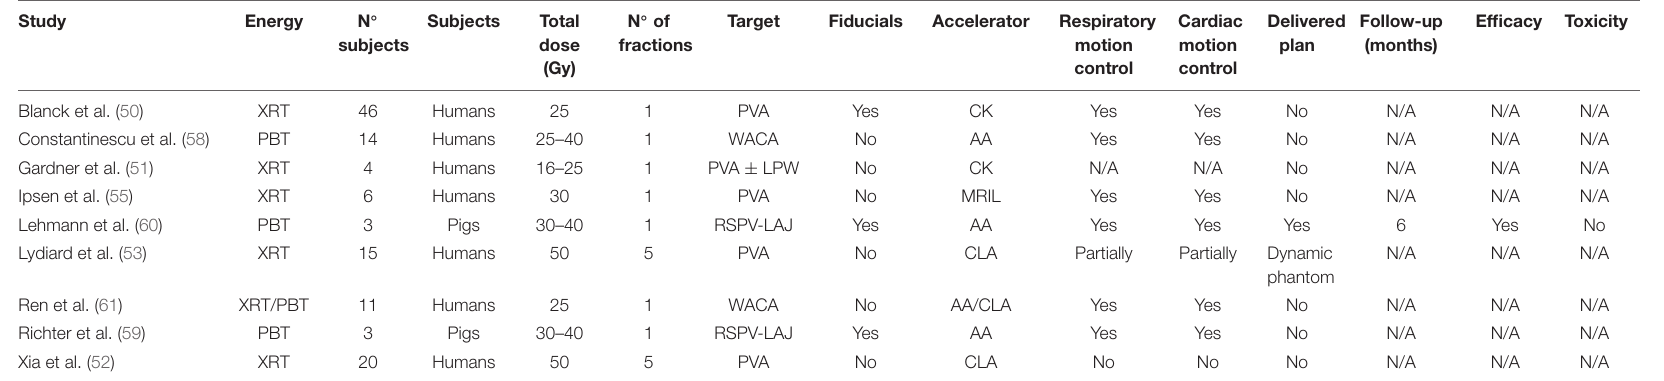
TABLE 2 | Main characteristics of the dosimetric photon and particle beam-based studies included in the